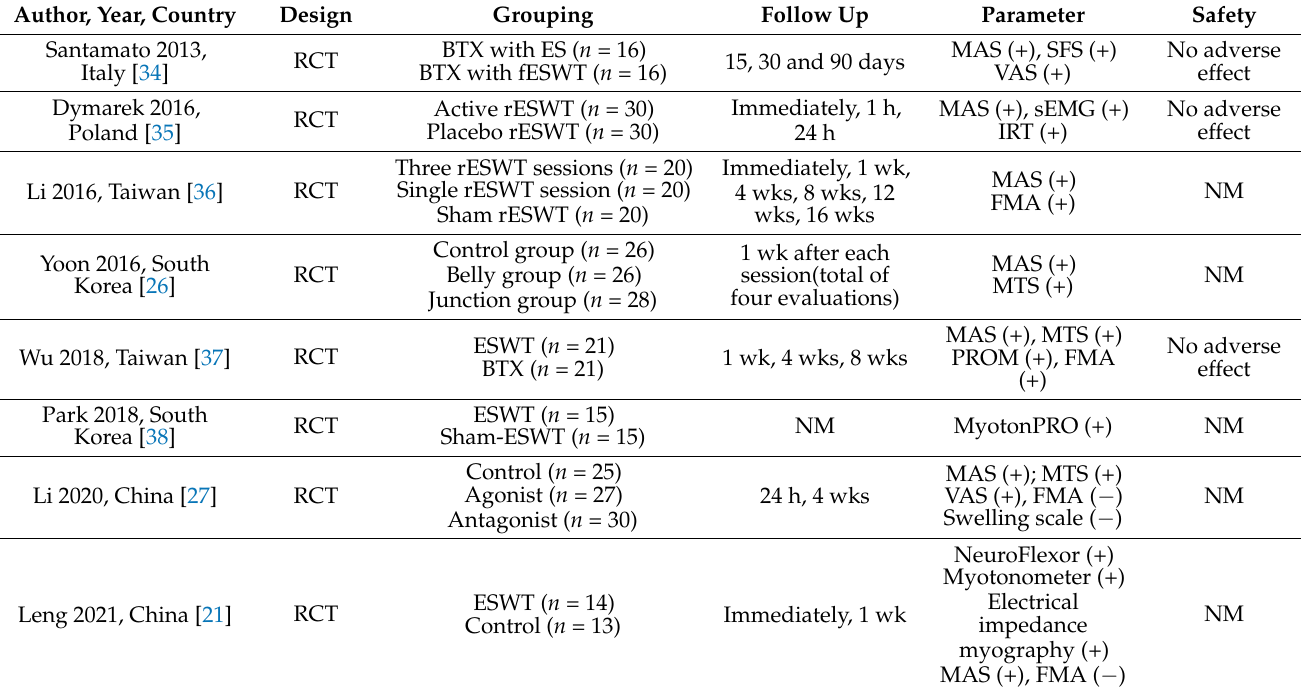
Table 1. Upper limb studies: design and outcome